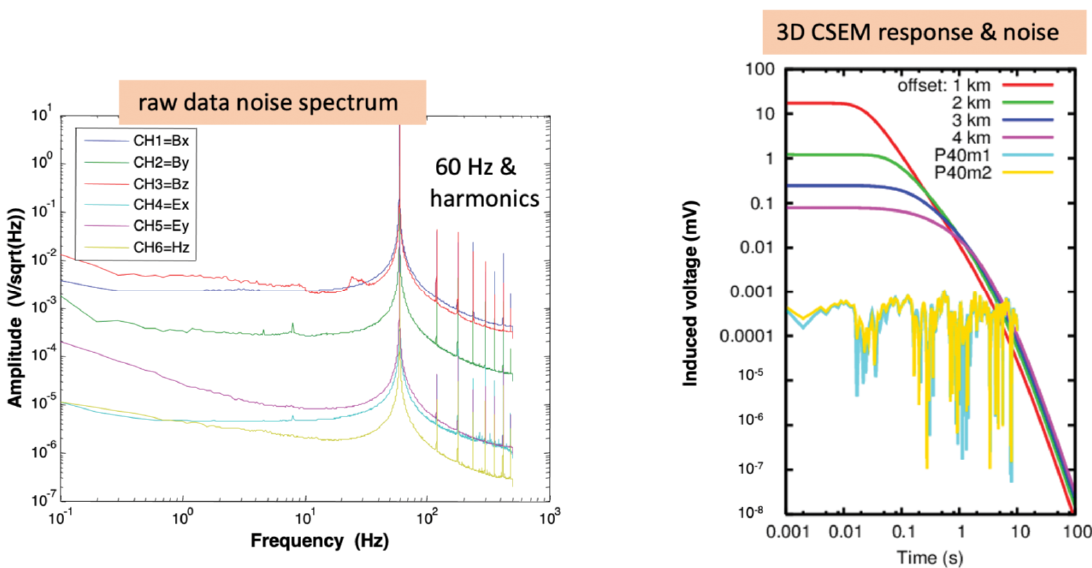
Figure 5. Noise spectra from on-site noise tests for a CSEM monitoring survey (after [2]) on the left. The different curves represent different electromagnetic fields. On the right are measured voltage responses for the magnetic field (dBz/dt) calculated for the 3D model in Figure 1. Superimposed on the right are the noise spectra after filtering. (After [2]). The black horizontal lines are different transmitter current switching periods.